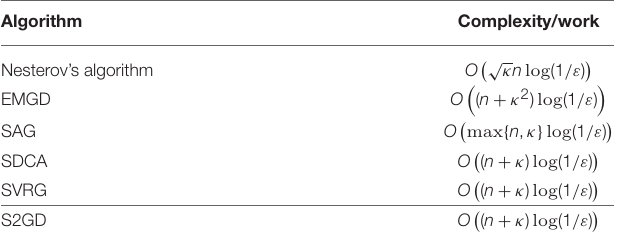
TABLE 1 | Comparison of performance of selected methods suitable for solving Equation (1). Algorithm Complexity/work Nesterov’s